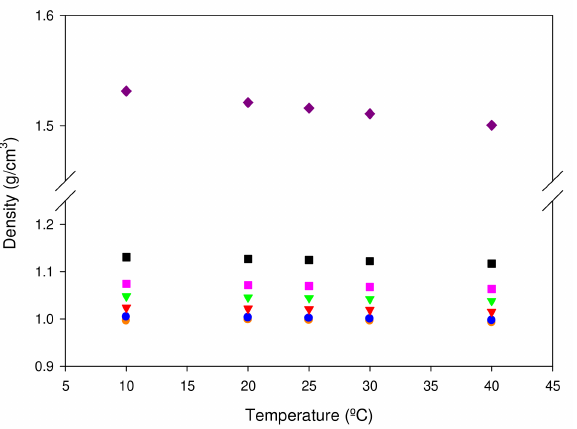
Figure 3. Density versus temperature of ( ) Water, ( ) 1IL/Water, ( ) 5IL/Water, ( ) 10IL/Water, ( ) 15IL/Water, ( ) 25IL/Water and ( ◆ ) IL. The existence of a network at all the IL/Water compositions formed by the FIL clusters which would percolate the continuous phase was evaluated by determining both dynamic viscosity ( µ ) and the complex viscosity and compared to that of water and neat (Figure 4).